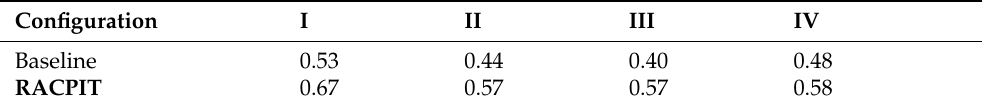
Table 3. Balanced accuracy of the baseline and RACPIT for all different configurations.